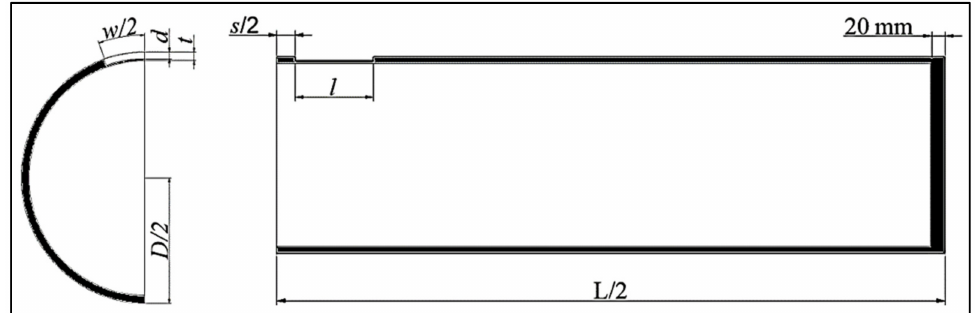
Figure 1. An annotated quarter pipe model used for FEA.